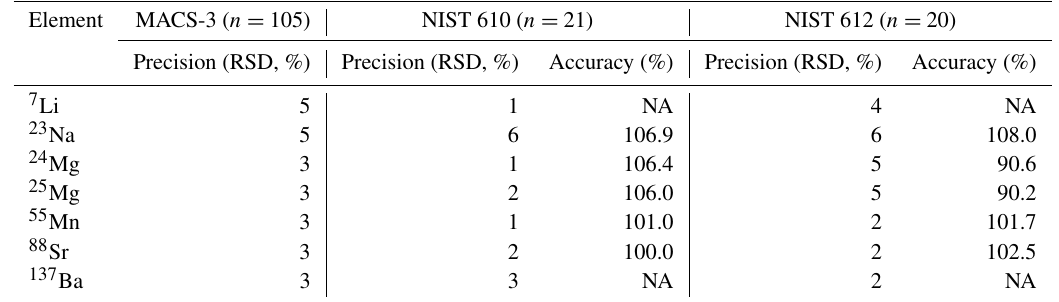
Table 1. Accuracy (RSD of n measurements) and precision (% of reference value) of three standards, including the calibration standard